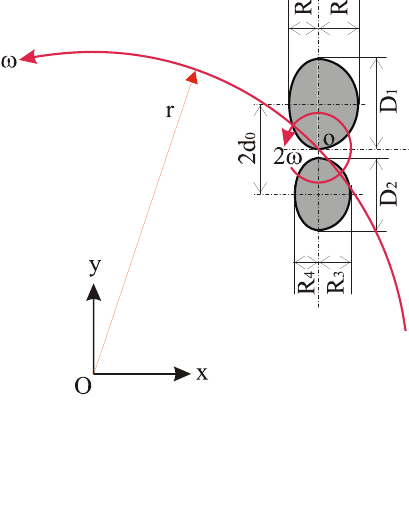
Figure 3. Synthetic image pattern and its